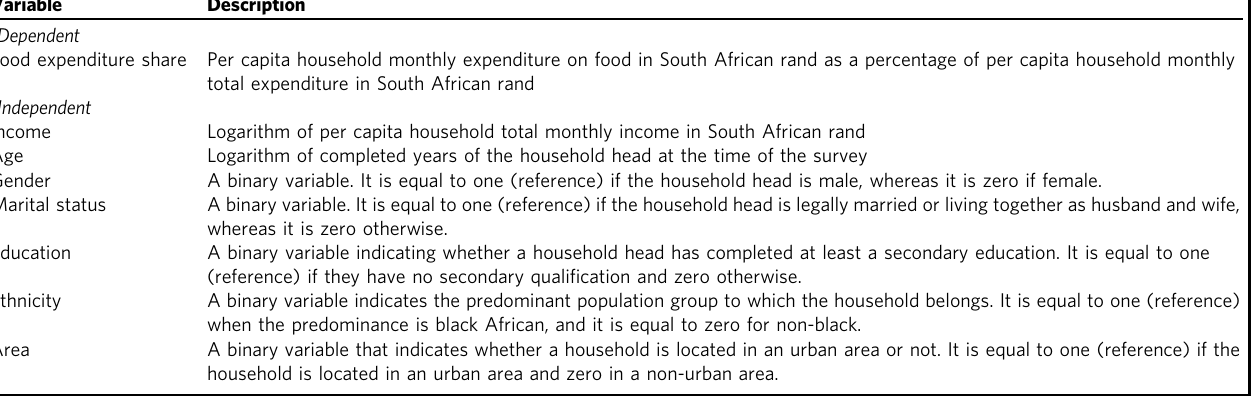
Table 1 Description of variables used in the